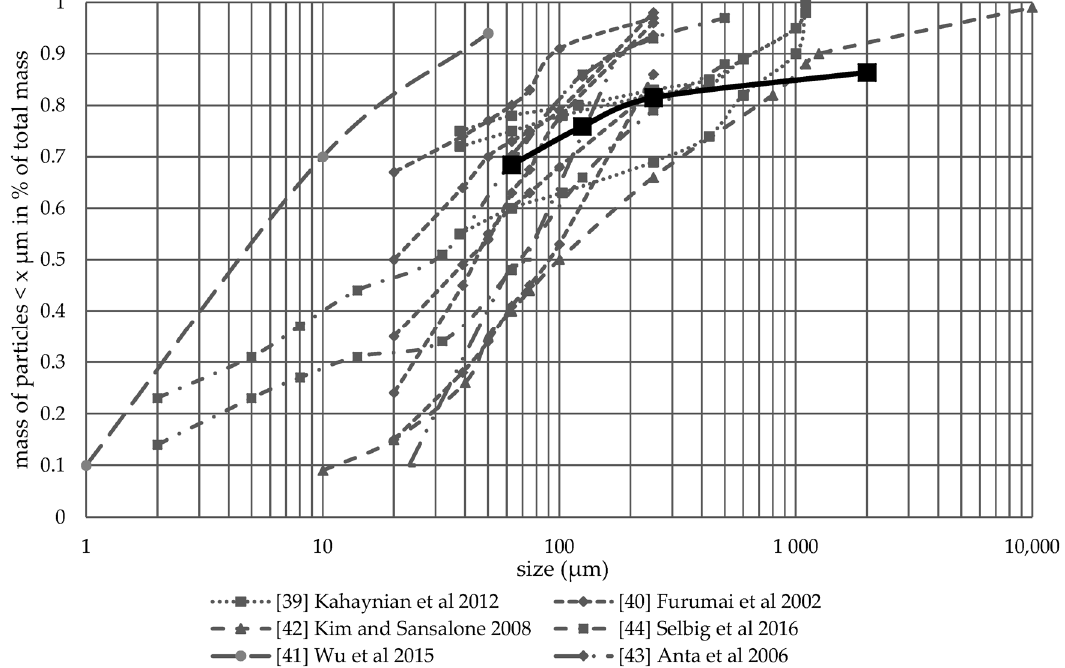
Figure 4. Comparison of particle size distribution. All cited studies investigated the particle size distribution of road